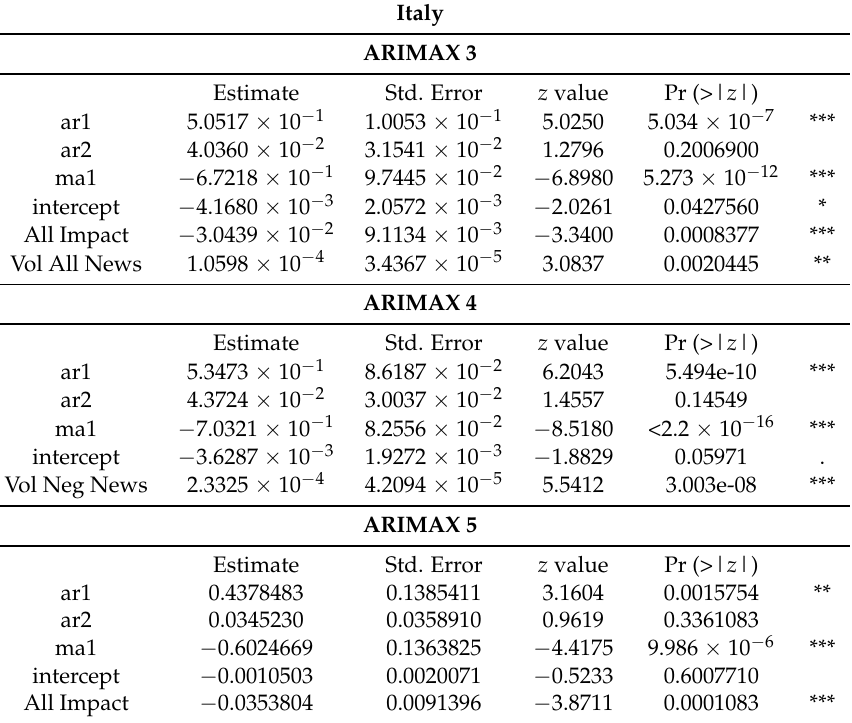
Table 18. z -test of coefficients for ARIMAX models in Spain for first difference of mean country